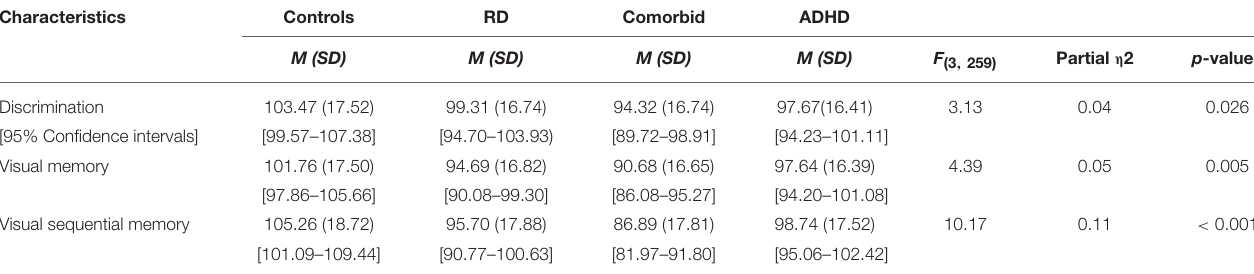
TABLE 2 | TVPS-R performance by group. Characteristics